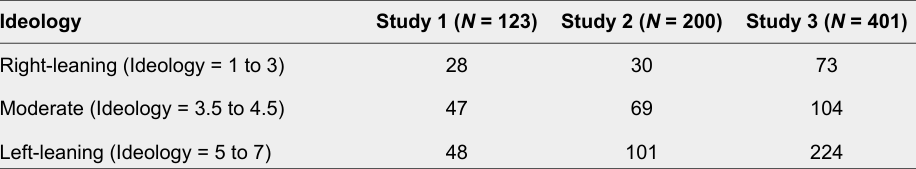
Frequency of Right-Leaning, Moderate, and Left-Leaning